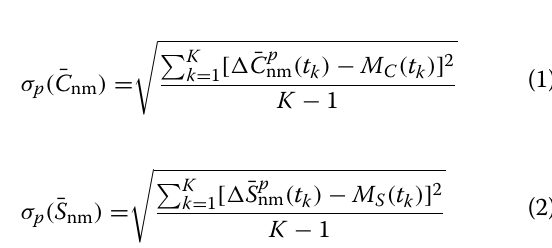
from the unfiltered fully normalized global spherical har- monic potential coefficients (cid:31) specific GRACE processing centers p ∈ 1, ..., P and the